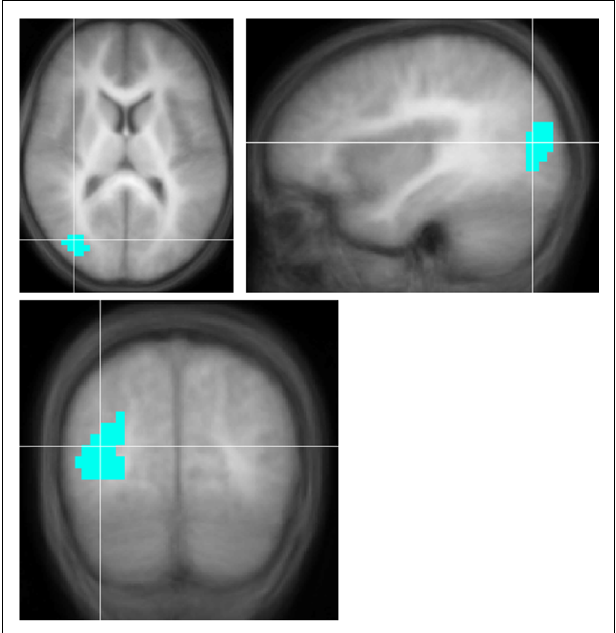
FIGURE 1 | Region with significantly smaller functional activation in children with severe-to-profound unilateral hearing loss for the fMRI audio–visual paradigm of a modified “TokenTest” (described in more detail in the text) compared to normal-hearing controls. Images in radiologic orientation. Slice locations (Talairach coordinate system): Z = + 12 mm (Axial); X = + 34 mm (Sagittal); Y = − 71 mm